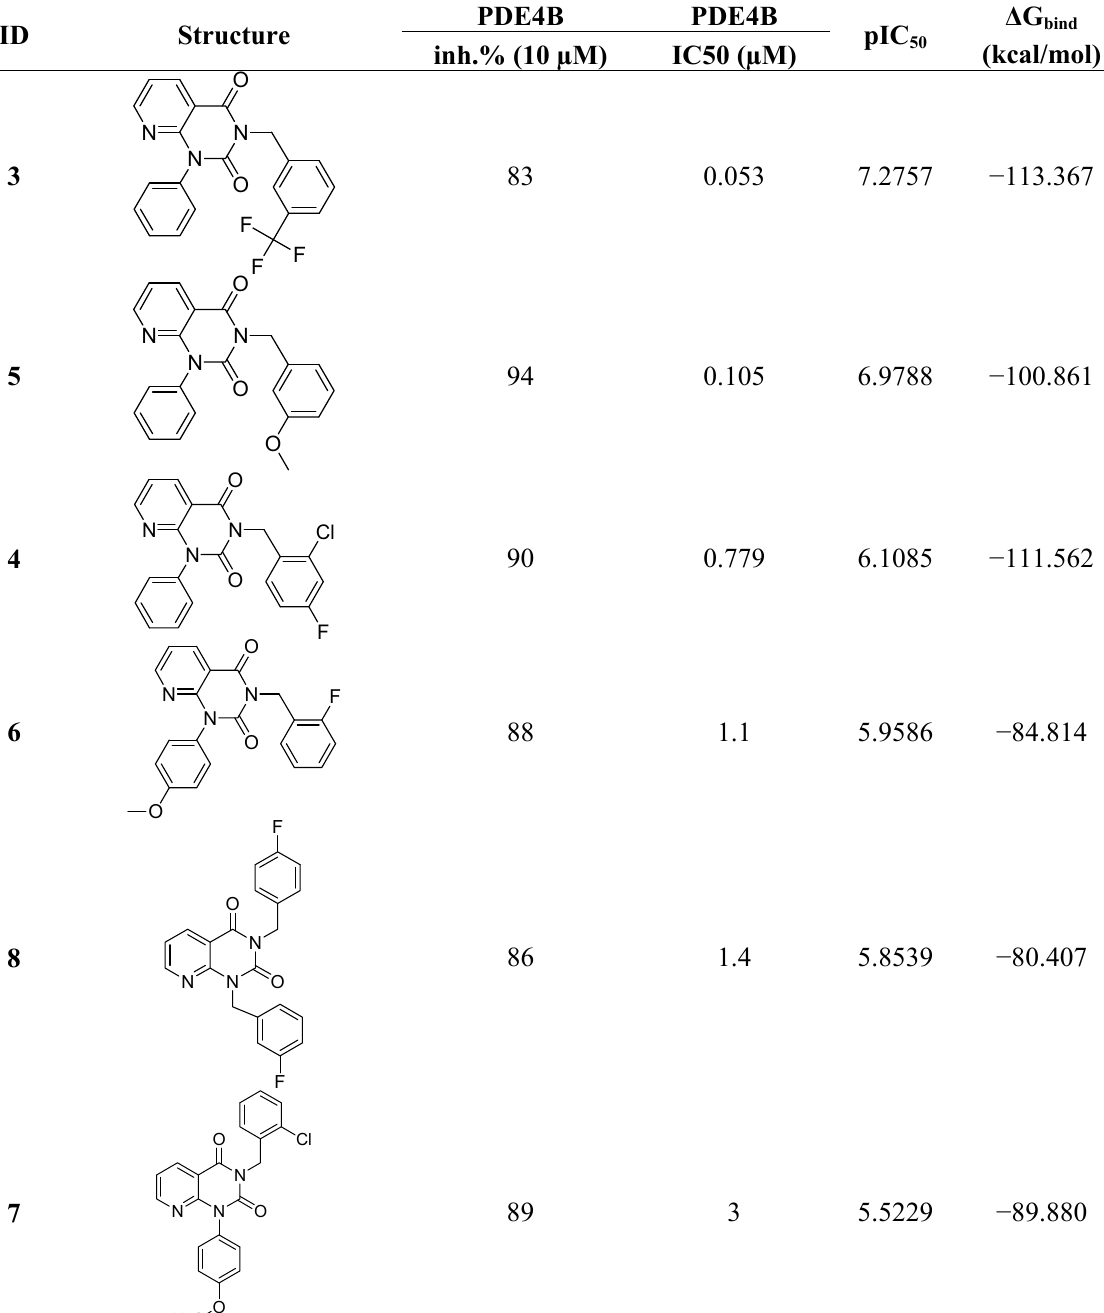
Table 7. Δ G values obtained from MM-GBSA calculation and experimental IC50/pIC50 bind values for ligands with the same